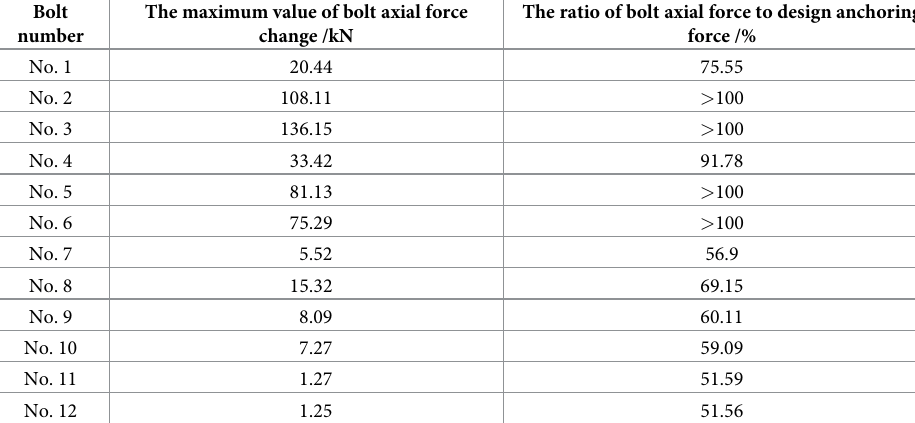
Table 2. Maximum axial force change of bolt.